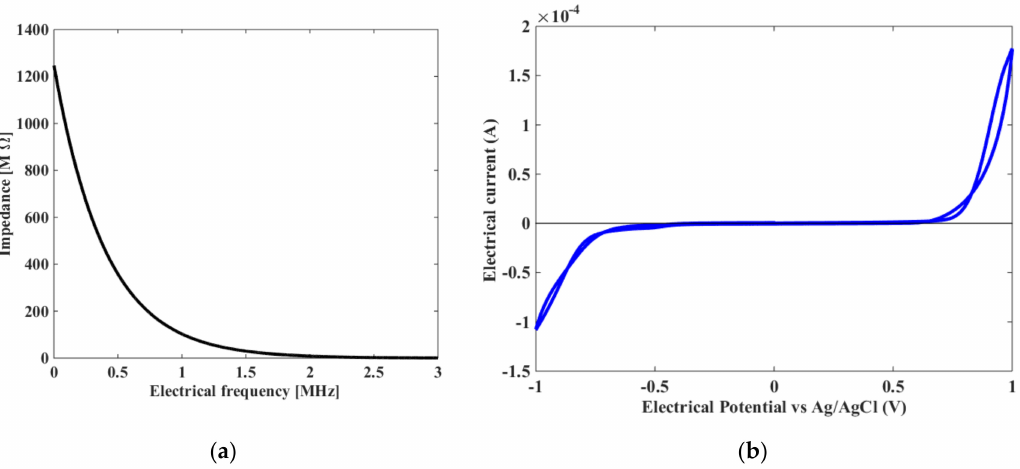
Figure 4. ( a ) Electrochemical impedance spectrum of the NiO film. ( b ) Direct current (DC) cyclic voltammetry of a NiO film in 0.5 M KOH solution. The starting potential was 0 V, upper potential was + 1 V, lower potential was − 1 V, and the applied scan rate was 10 mV /